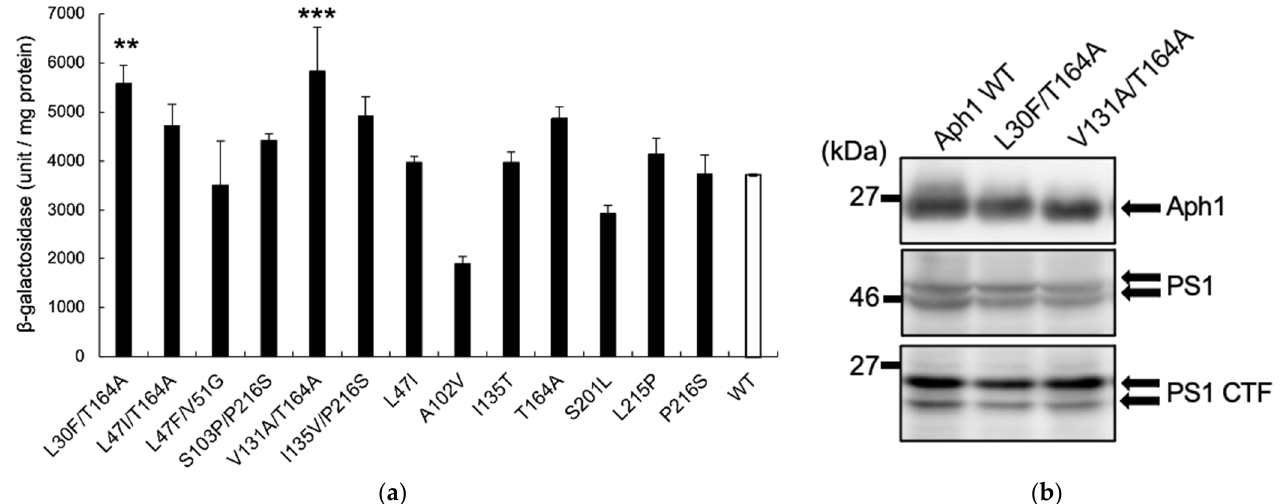
Figure 3. β -Galactosidase activity of Aph1 active mutants in the γ -secretase complex. ( a ) β -Galactosidase activity was assayed in cells expressing the Aph1 wild-type (WT) or active mutants, PS1, FLAG-Pen2, and nicastrin. The experimental conditions were identical to Figure 2. ( b ) Expression of WT or Aph1 mutants and PS1 in lysates were analyzed by immunoblotting using specific antibodies. Endoproteolysis of PS1 was detected by the production of mature fragment PS1 CTF. Asterisks on each bar indicate p < 0.01 (**) or p < 0.001 (***) ( a ).